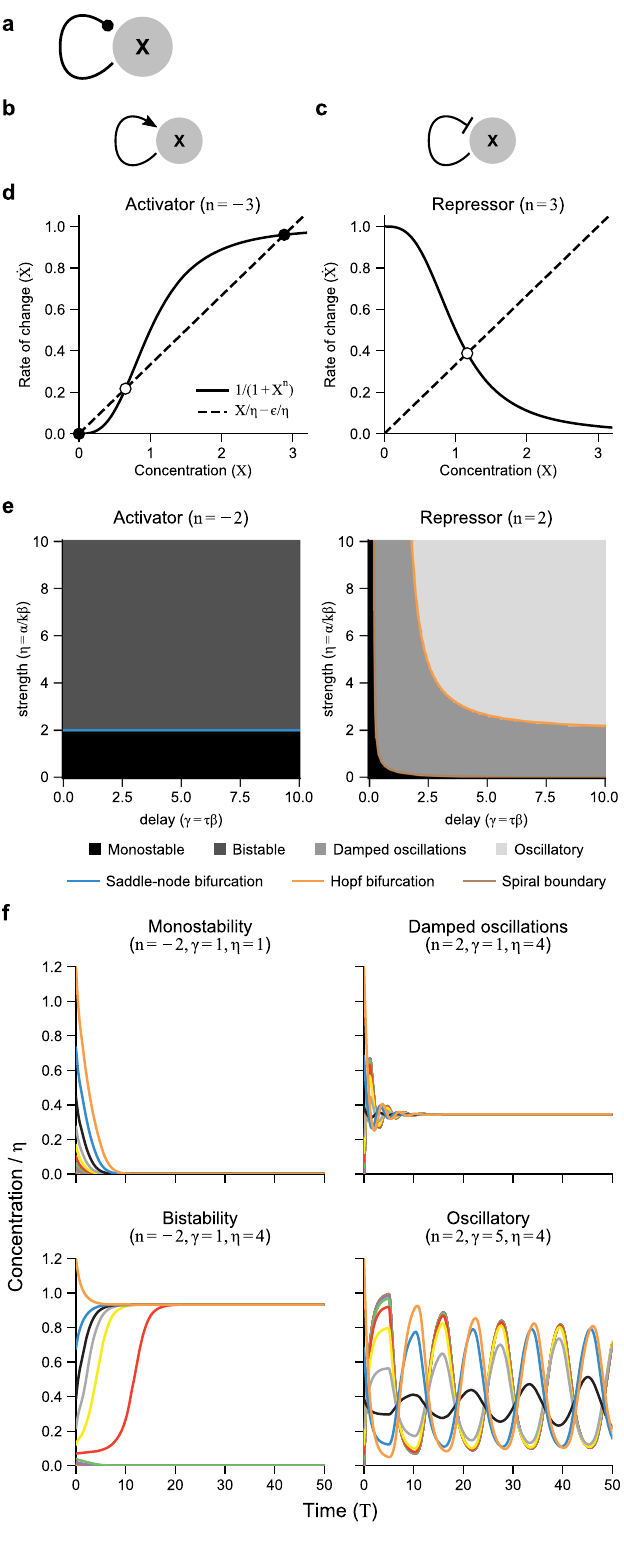
Fig. 4 The complete phase diagram for the autoregulation network motif has analytically derivable parameter regions for bistability, monostablility, monostablility with damped oscillations, and oscillations. a The autoregulation network motif, with a dotted arrow indicating either ( b ) self-activation or ( c ) self-repression. The two cases are given by n < 0 (activation) and n > 0 (repression). d Stable (black circles) and unstable (white circles) fi xed points for activator and repressor cases are given by the intersection of the regulation (solid) and degradation + leakage (dashed) lines. Note that activators can have 1, 2, or 3 fi xed points, whereas repressors always just have one. e Parameter space showing all possible behaviors for autoregulation with delay. Shading shows simulation results (with an interval of 0.1 for both γ and η axes) and curves show the analytically derived bifurcation boundaries. See Supplementary Fig. 3a for cases − 3 ≤ n ≤ 3 and Supplementary Fig. 3b for boundaries in η vs. n parameter space. f Representative simulation curves for the four qualitatively different behaviors, with different colors representing different initial conditions (see “ Methods ” ). ϵ =